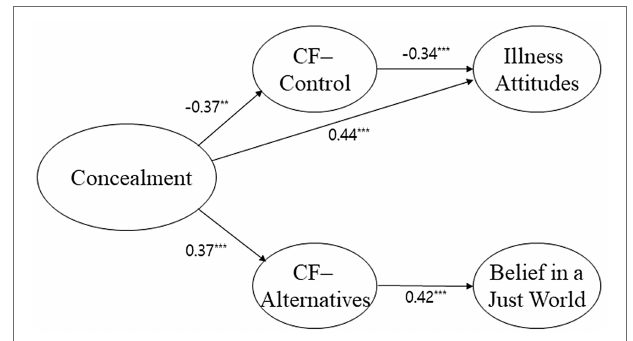
FIGURE 3 | Verified Structural Model for Chinese